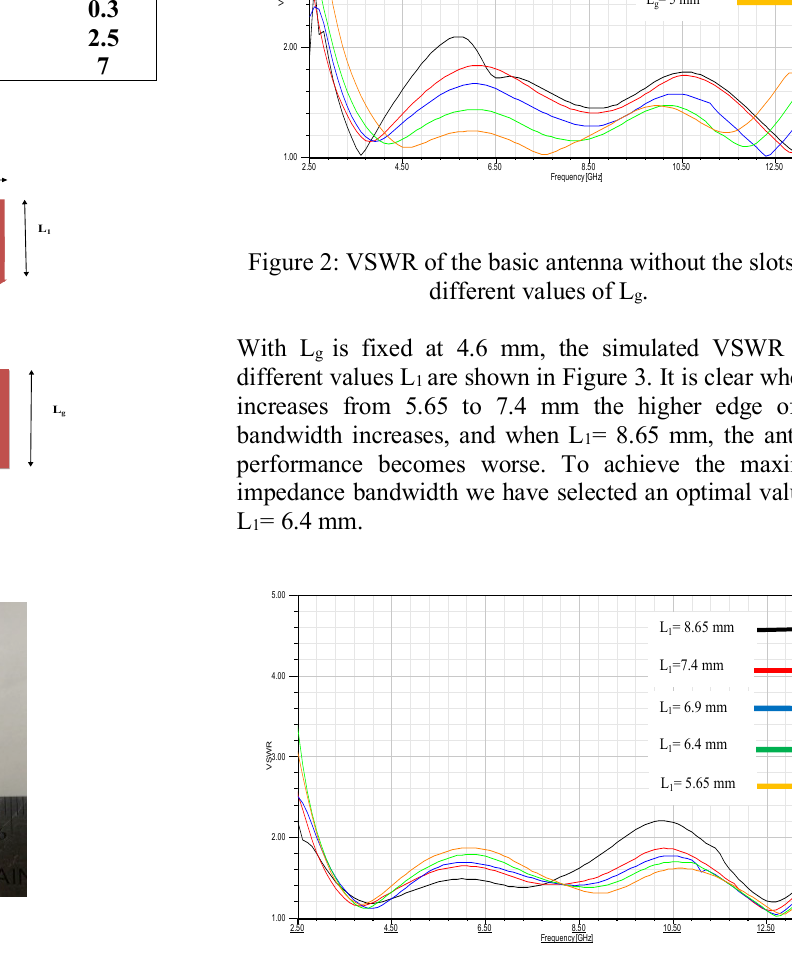
Figure 3: VSWR of the basic antenna without the slots for different values of L 1